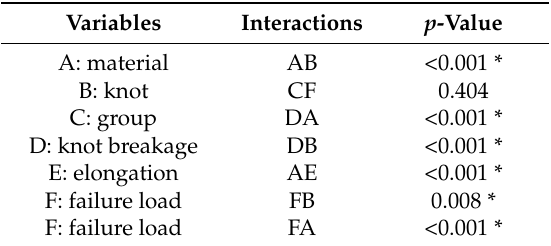
Table 2. Analysis of interaction of